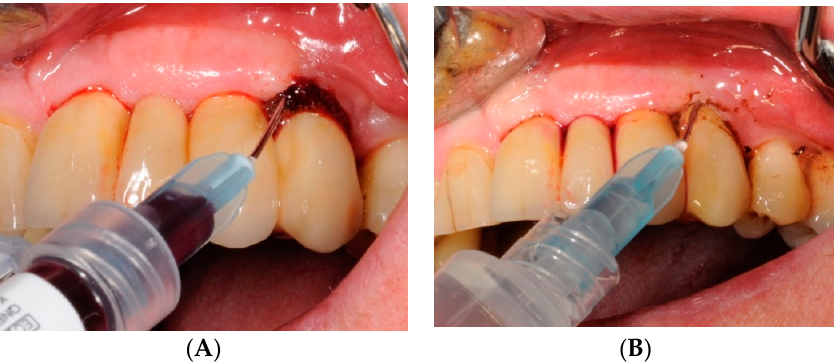
Figure 6. HBX application into the periodontal pocket (starting from the base) with a delivery syringe ( A ) and saline solution irrigation ( B ) after 60 sec to flush-out the product. Antibiotics 2019 , 8 , x FOR PEER REVIEW